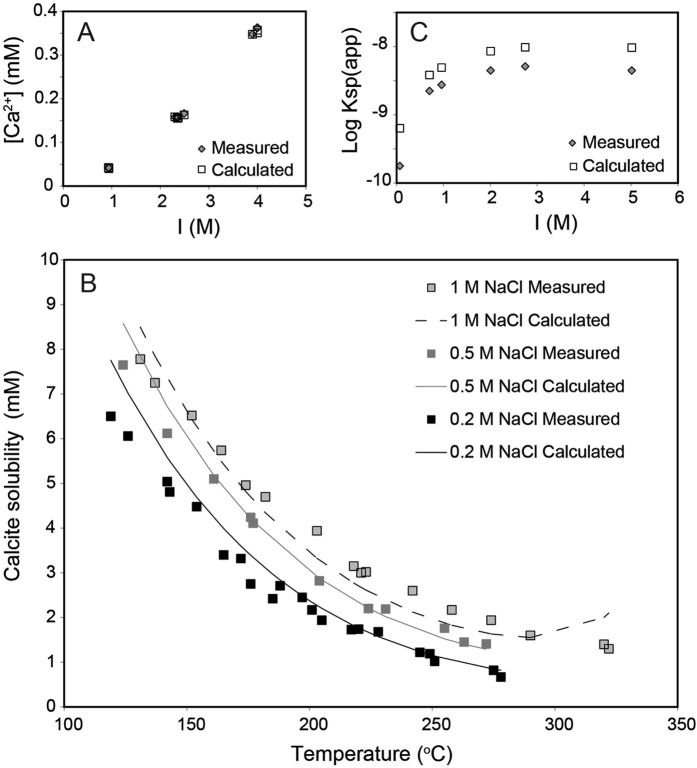
Comparison of PHREEQC modelling with experimental data for solubility of (A) calcite at 25 °C and high ionic strength65; (B) calcite at high ionic strength and elevated temperature66; (C) rhodochrosite at 25 °C and high ionic strength69.